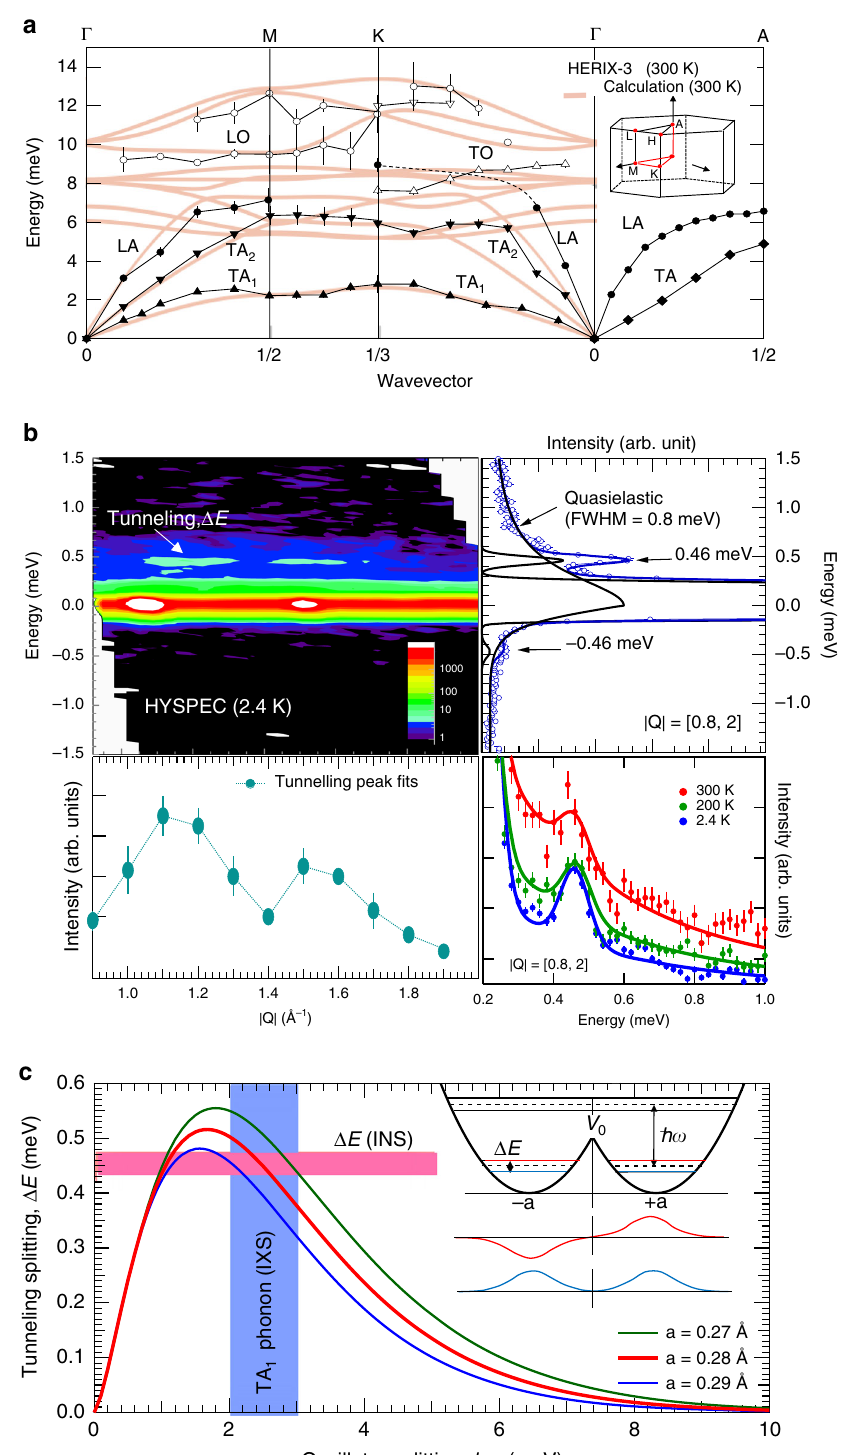
Fig. 3 Lattice dynamics and atomic tunneling splitting. a Phonon dispersion measured using inelastic X-ray scattering for longitudinal (circles) and transverse (triangles) polarization, along with fi rst-principles simulations (peach lines). The low-energy transverse acoustic phonon (TA 1 ) is polarized along the c axis and is responsible for large-amplitude thermal displacements along this direction. b High-energy resolution inelastic neutron scattering spectra measured on BaTiS 3 powder at 2.4 K. An excitation is observed at 0.46 meV. The top right panel shows the spectrum integrated over momentum, Q . The bottom left panel shows the tunneling peak intensity versus Q , and the bottom right panel shows the momentum-integrated spectrum at different temperatures. c Tunneling splitting energy, Δ E , versus oscillator energy ( ℏ ω ) from an analytical model for three double-well separation distances. The inset shows the double-well parameters and the symmetric and antisymmetric wave functions. The well separation predicted from the tunneling splitting (intersection of the red curve and pink horizontal bar) agrees with that inferred from the TA 1 phonon energy (intersection of the red curve and blue vertical